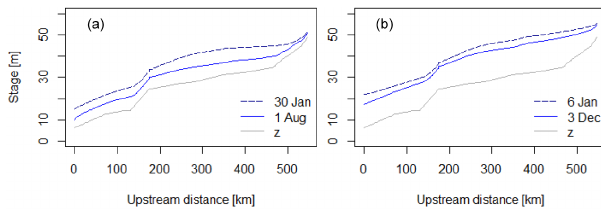
Figure 10. Longitudinal surface water profile over the Kapuas river reach from Sanggau to Putussibau; z is bed elevation. (a) Wa- ter stages are plotted for 30 January and 1 August, displaying the falling limbs of the hydrograph. (b) The rising limbs, when the wa- ter levels are increasing, are shown for 3 December 2014 and 6 Jan- uary